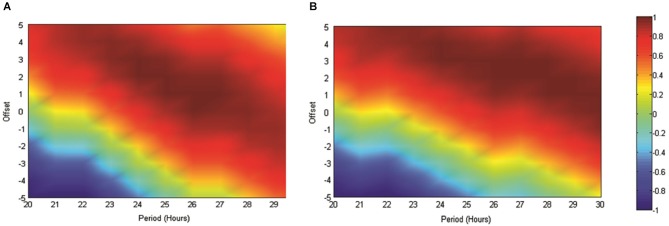
(A) The matrix produced by correlating an array of sinusoids with period x and offset y hours against the artificially generated sine wave (25 h period and 2 h offset) used as a reference throughout this study. As indicated in the scale, “hotter” colors represent increasingly positive correlations, while cooler colors represent increasingly negative correlations. (B) Illustrates the correlation matrix produced by correlating an array of sinusoids with period x and offset y against the mean normalized spontaneously generated hippocampal theta frequency.